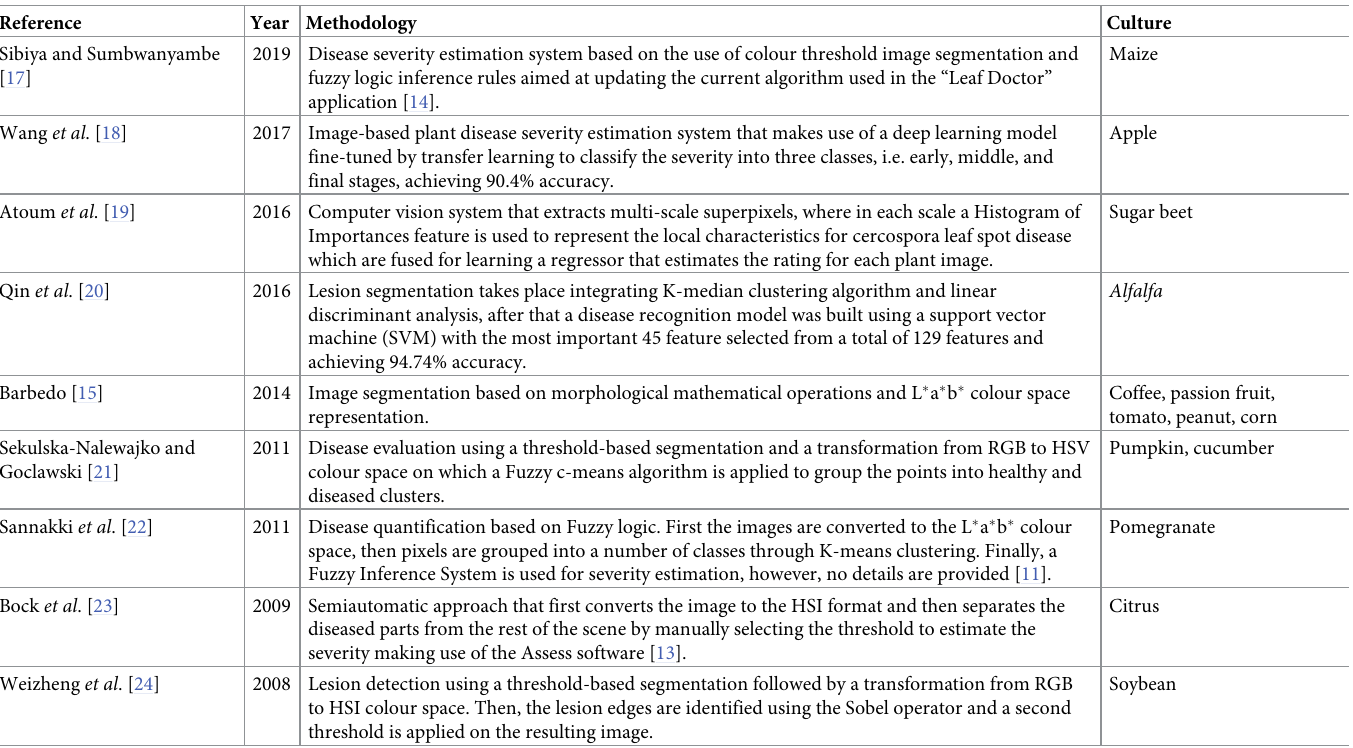
Table 1. Overview of plant disease severity quantification